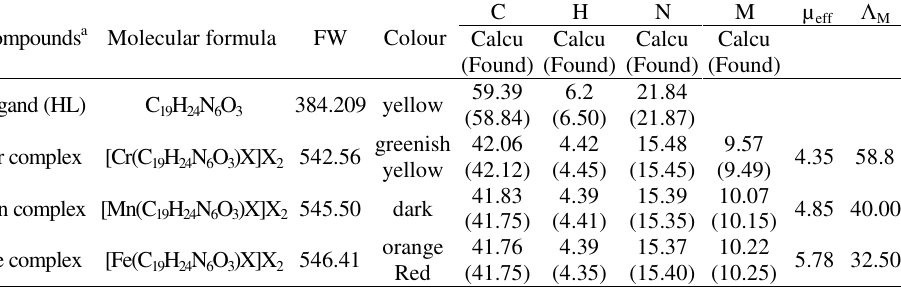
Table 1. Elemental analysis in %, molar conductance ( Λ magnetic moment (µ ) in µ of the Schiff base ligand and its metal complexes. eff B